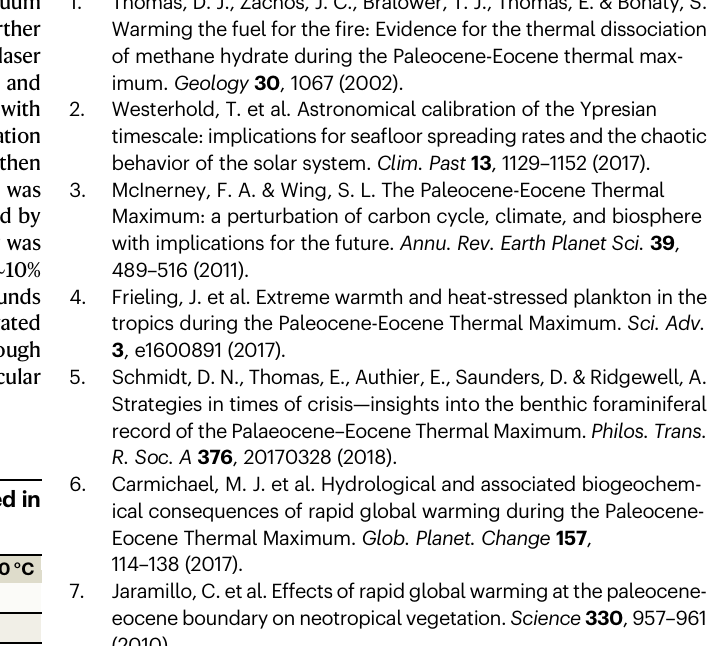
isothermal steps were used to increase peak separation. The second peak varies in sizeacrossthesamples,beingbetween12and51%ofthesizeofthethirdpeak,and thusistoosmallforaccurateisotopicmeasurements.Includingthesecondpeakas partofthehydroxylpeakinisotopeanalysisleadstoonlysmallchangesinreported values, and does not change the overall trends in δ 18 O OH and δ 2 H OH